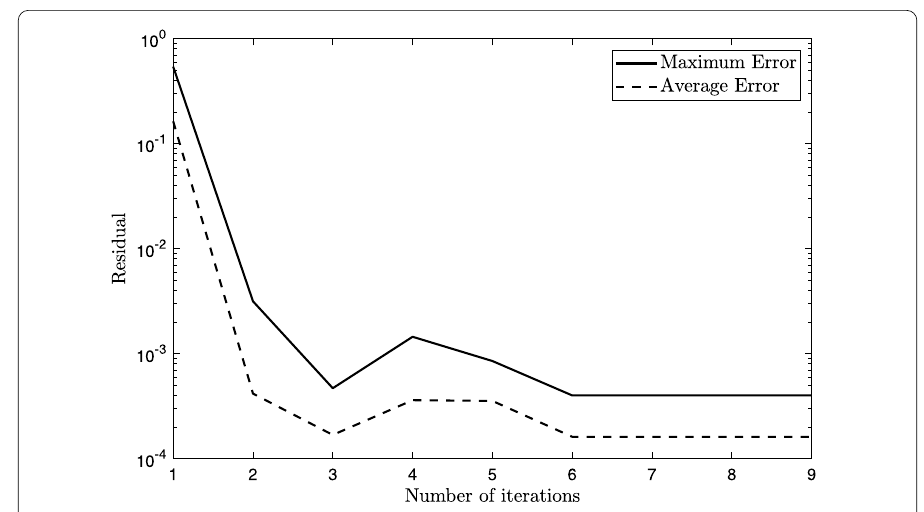
Figure 4 Evolution of maximal and average residuals in each iteration of classical greedy algorithm